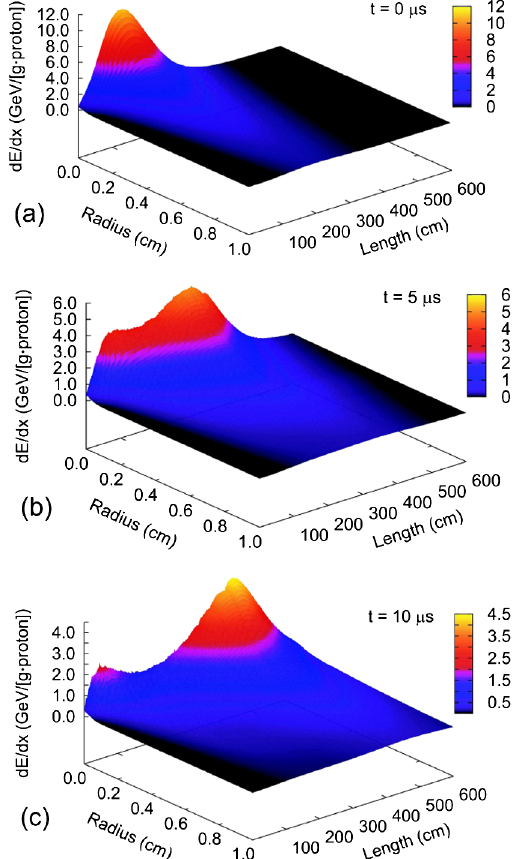
FIG. 3. FLUKA calculations of energy deposition of a single 7 TeV LHC proton in a solid carbon cylinder having radius r ¼ 5 cm , length L ¼ 6 m , with facial irradiation, beam spot size characterized by standard deviation (cid:1) ¼ 0 : 5 mm ; (a) using solid density of 2 : 28 g = cm 3 ; (b) using the density distribution pro- vided by the BIG2 at t ¼ 5 (cid:2) s (second iteration); and (c) using the density distribution provided by the BIG2 at t ¼ 10 (cid:2) s (fourth